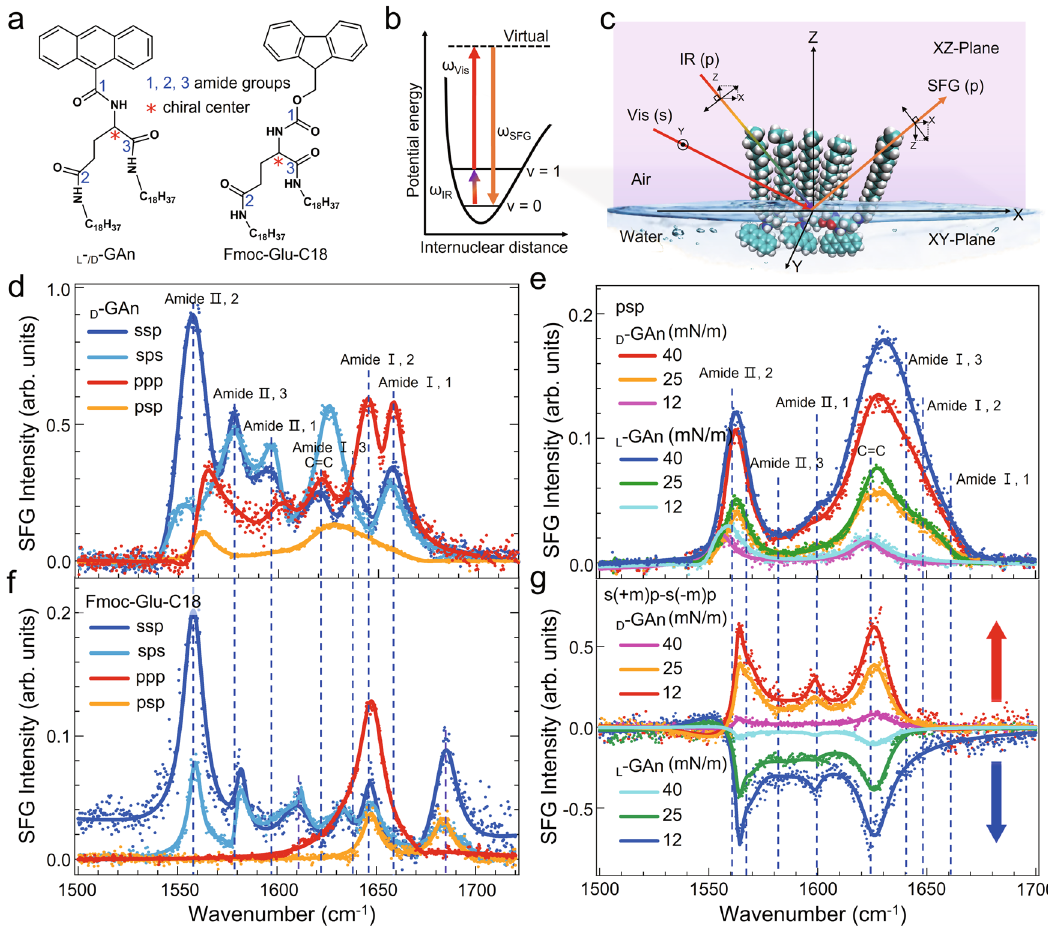
Fig. 1 | SFG spectral characteristics of assemblies in the amide region. a The molecularstructuresof L - /D -GAnandFmoc-Glu-C18.Thesequencenumbers(1,2,3) representthree amide bonds indifferent positions of the molecule,and * indicates theasymmetriccarbonatom. b SFGenergyleveldiagram.Energylevelcode:Virtual (virtualelectronicstate), ν =1(vibrationalstate), ν =0(groundstate). c Aschematic representation of the psp chiral polarization setting to detect the chiral supramo- lecular monolayer formed by the self-assembly of L - /D -GAn molecules at the inter- face. (The projection of the electric fi eld of p-polarized and s-polarized light